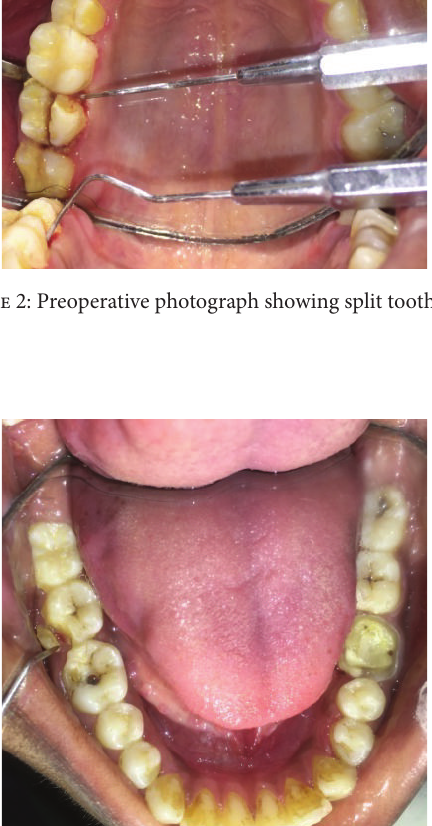
Figure 6: Preoperative radiograph of 46.